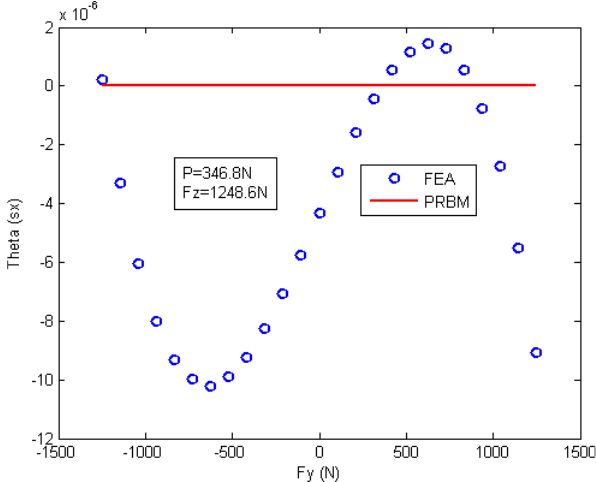
Figure 10. Twisting angle about the x axis. Figure 11. Bending angle about the z